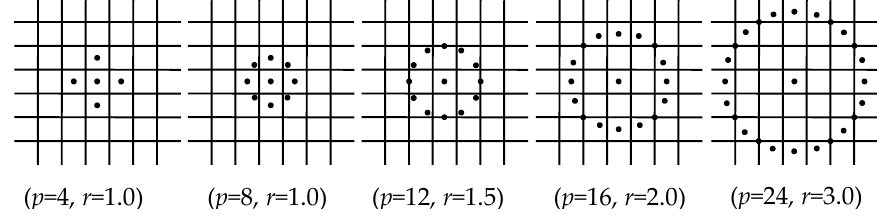
Figure 1. LBP parameter samples.